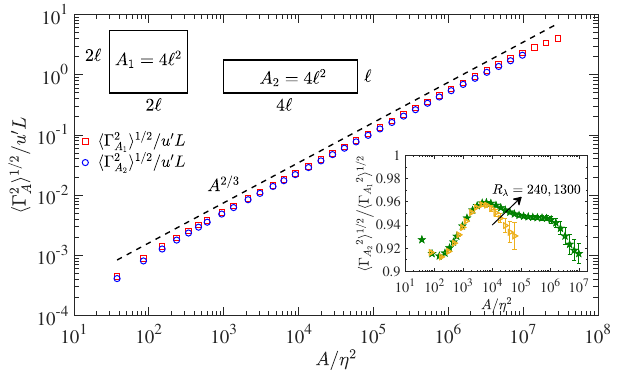
FIG. 4. Circulation standard deviation as a function of the area A of the figure-eight loop (shown in the inset), calculated in a ¼ 650 . The edge lengths of the figure-eight loop 4096 3 grid at R λ are chosen such that L 1 − L 2 ¼ Δ , where Δ is a fixed constant. Symbols (square), (circle), (diamond), (asterisk), and (triangle) correspond to Δ = η ¼ 2 , 4, 8, and 16, respectively. The standard deviations collapse for different figure-eight loops with the same area and follow the scalar area rule in IR, as evidenced by the closeness to the A 2 = 3 scaling. The linear area dependence for small A is shown, and the tendency to saturation for large areas is also apparent. Both these tendencies also occur in Fig.